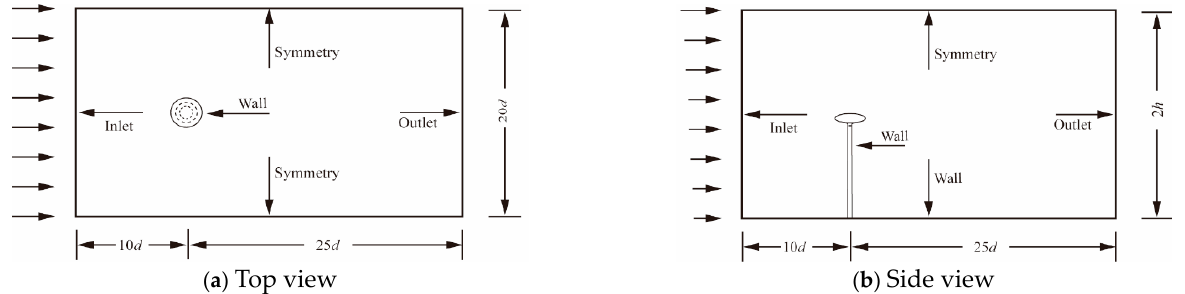
Figure 7. Schematic diagram of the calculation domain size and boundary conditions.